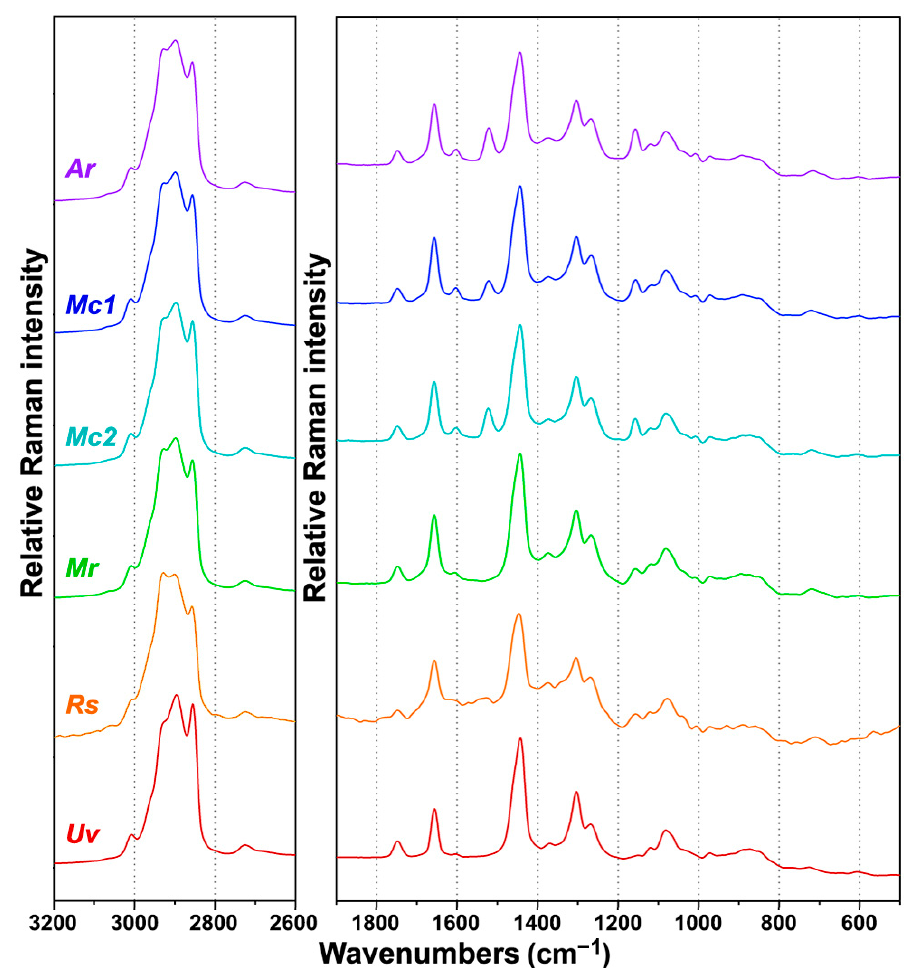
Figure 4. FT-Raman spectra of Mucoromycota oleaginous filamentous fungi cultivated under the standard growth condition (Ca1 and Pi1): Amylomyces rouxii ( Ar ), Mucor circinelloides VI 04473 ( Mc1 ), Mucor circinelloides FRR 5020 ( Mc2 ), Mucor racemosus ( Mr ), Rhizopus stolonifer ( Rs ), and Umbelopsis vinacea ( Uv ). All spectra were preprocessed and plotted with offset for better viewing.